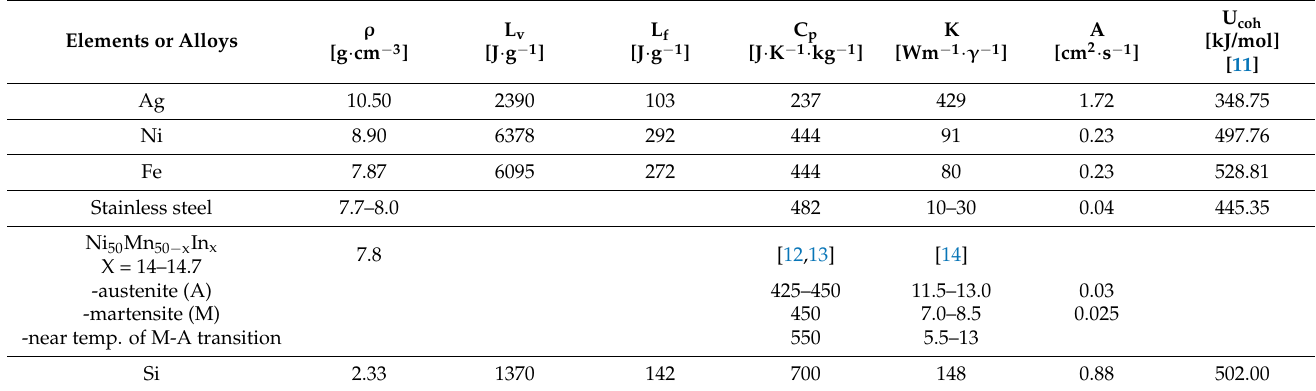
Table 2. Physical constants of the materials considered (partially according to Table 1 of [10]).